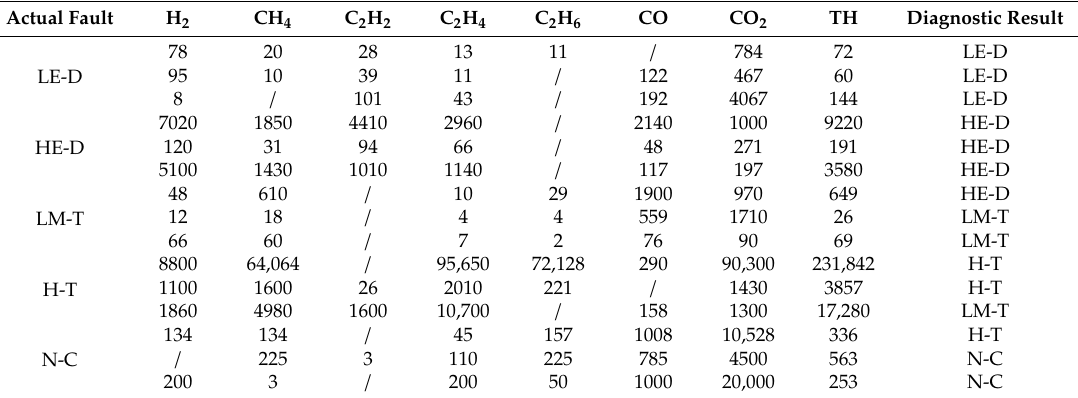
Table 12. DGA data information of [18].